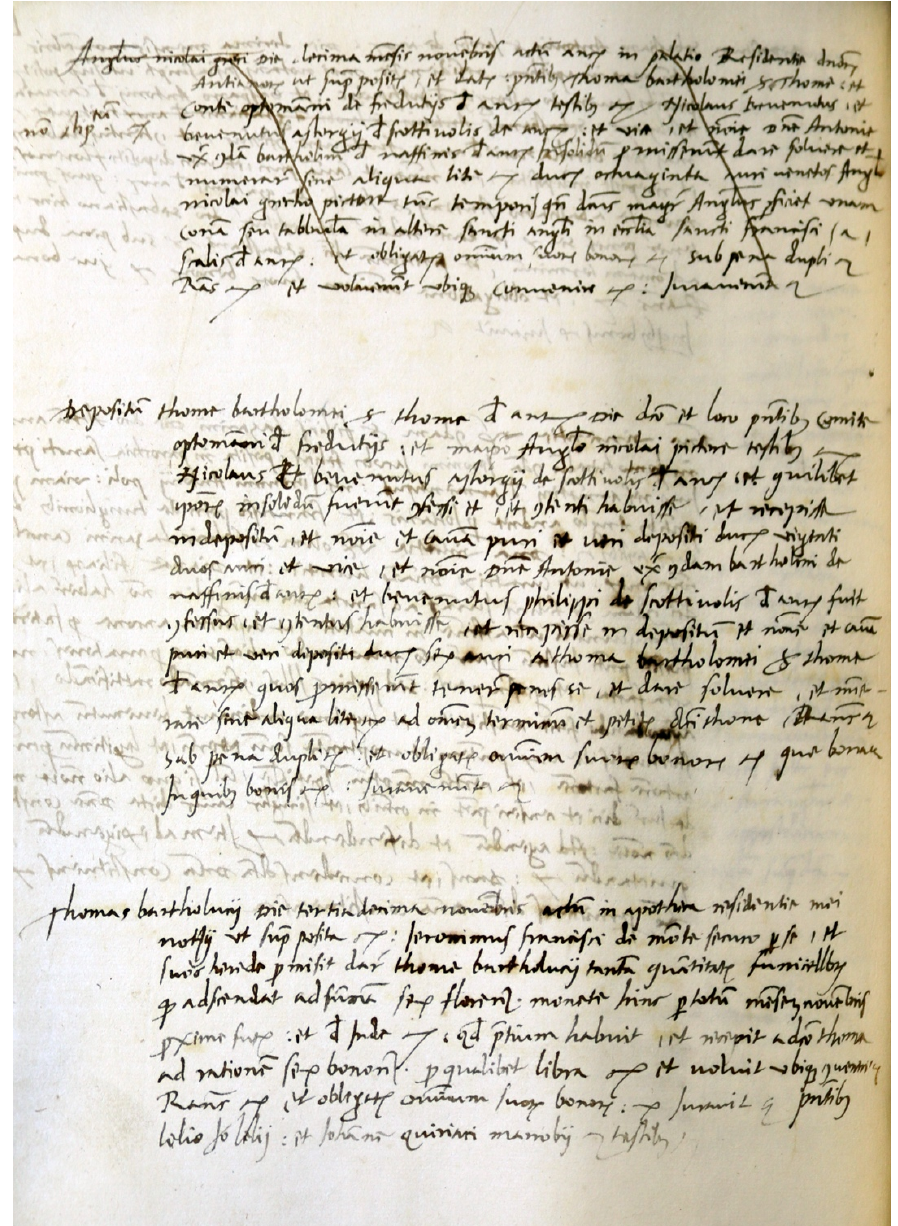
Figure 1. Acts documenting the commission of the Scottivoli altarpiece (ASA, ANA, vol.